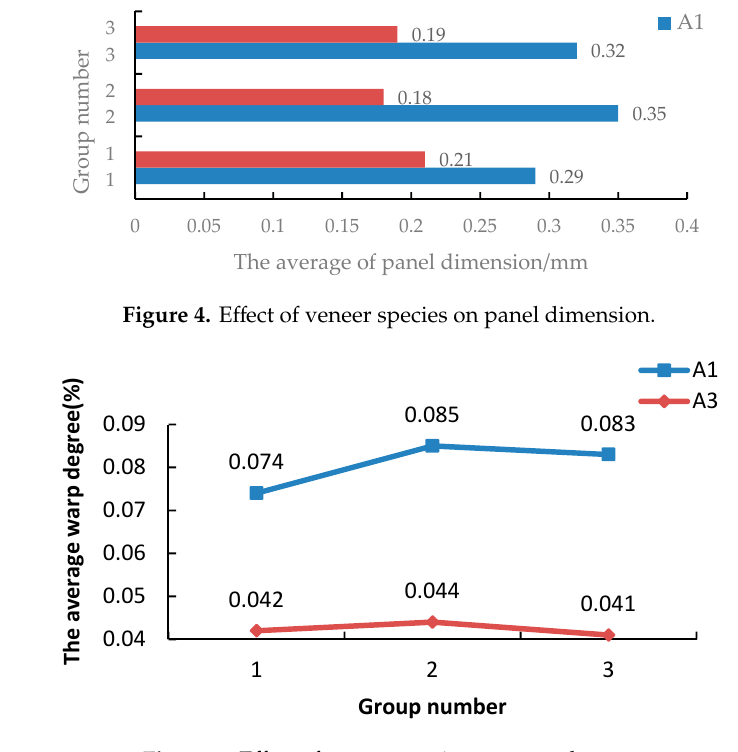
Figure 5. E ff ect of veneer species on warp Figure 5 . Effect of veneer species on warp degree. Figure 5 . Effect of veneer species on warp degree.